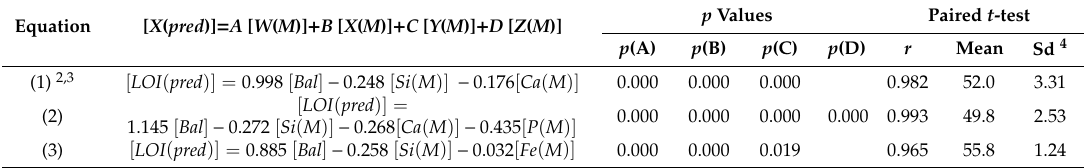
Table 2. Multiple linear equations for the prediction of LOI 1 from the Bal 2 readings obtained by the PXRF using the Mining (M) method.